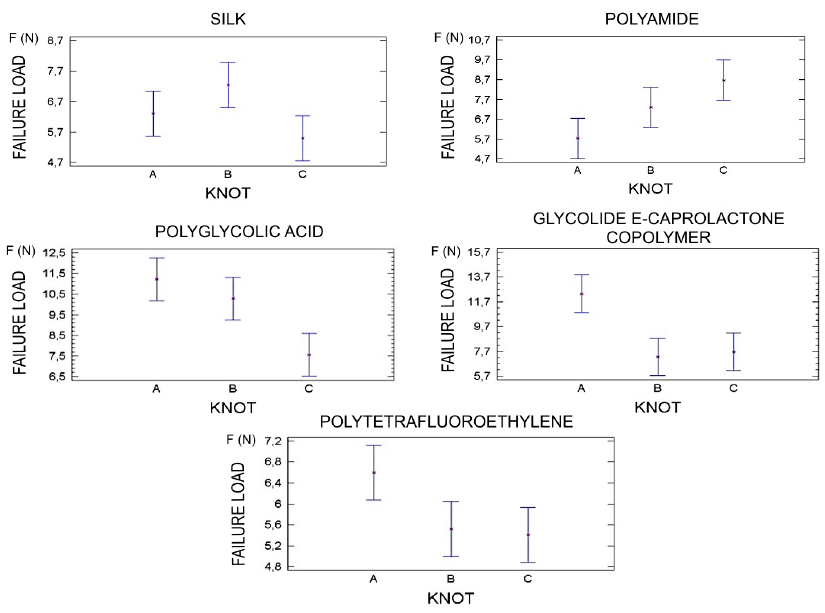
Figure 5. Knot configurations failure load according to the suture material used.